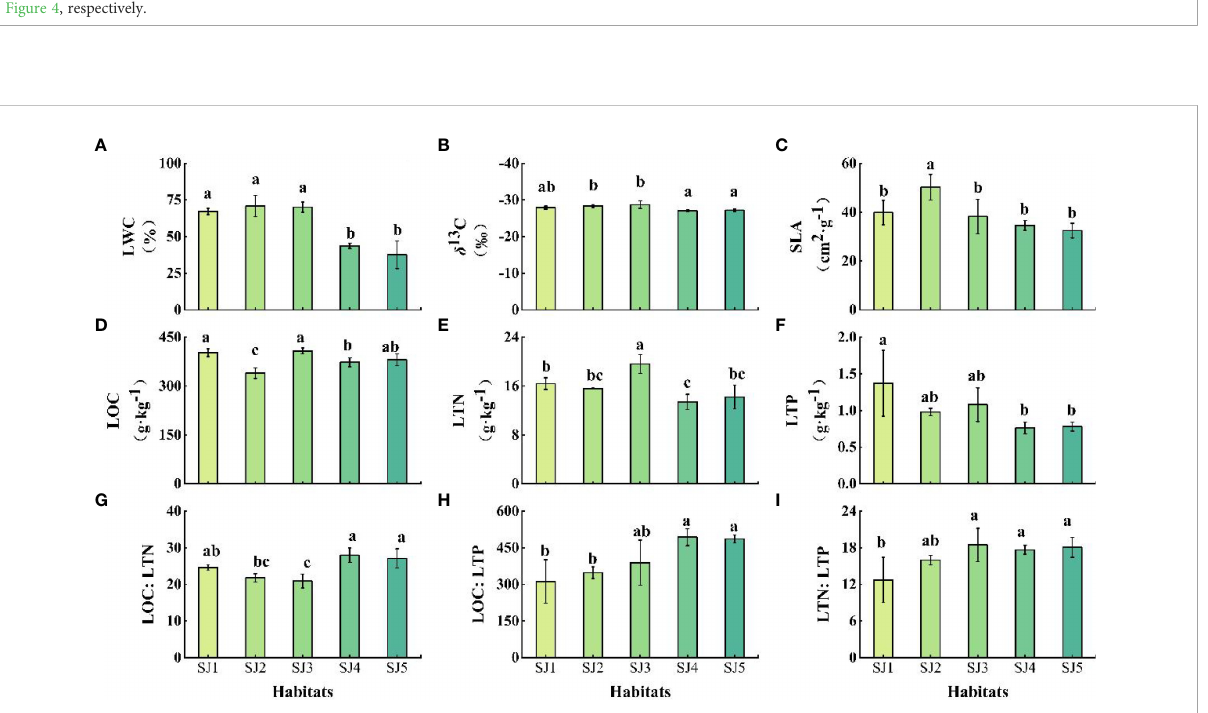
FIGURE 3 Vertical soil water content pro fi les of the different habitat conditions in the Daliyabuyi oasis. Note: Different lowercase letters indicate signi fi cant differences among the habitats (P < 0.05). Error bars indicate standard errors of the mean for triplicate measurements. The abbreviations of the leaf functional traits and different habitats are the same as in Table 2 and Figure 1, respectively. (A) LWC; (B) d 13C; (C) SLA; (D) LOC; (E) LTN; (F) LTP; (G) LOC: LTN; (H) LOC: LTP; (I) LTN: